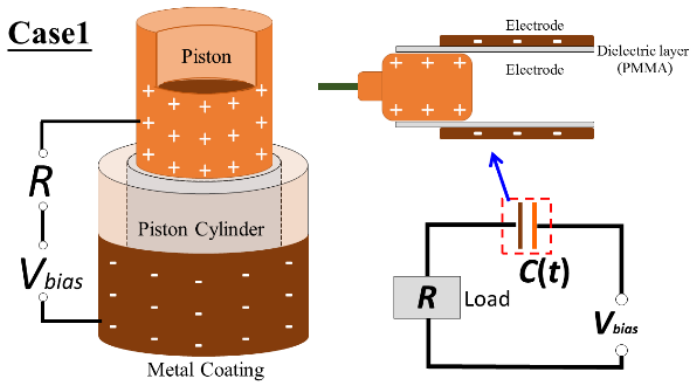
Figure 5. Schematic and equivalent circuit diagram of energy harvesters.